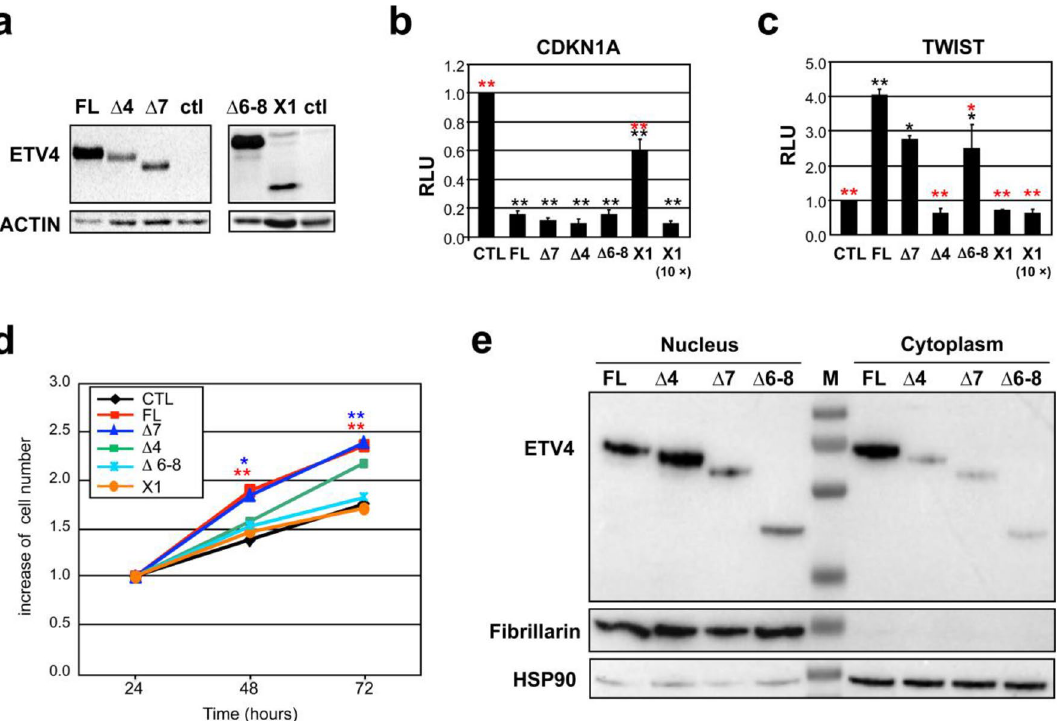
Figure 4. Functional characterization of proteins translated from the alternative ETV4 transcripts. ( a ) Western blot analysis of ETV4 isoforms expressed from 4 specific expression vectors: ETV4-∆4, ETV4-∆7, ETV4- ∆6–8, and ETV4-X1. FL, cells transfected with a vector expressing the full-length ETV4 (ETV4-FL). CTL, cells transfected with the empty vector. ( b-c ) ETV4 splice variants transcriptional activity measured by luciferase reporter assays. The vectors encoding each one of ETV4 splice variants or ETV4-FL have been transfected in RWPE cells along with a vector containing part of CDKN1A ( b ) or TWIST1 ( c ) promoter upstream firefly luciferase. Relative luciferase units (R.L.U.) is the firefly/renilla ratio of each variant compared to that obtained by control (CTL, cells transfected with the empty vector). The data represent mean ± sem from at least three independent experiments performed in triplicate: * P < 0.05, ** P < 0.01 (black asterisks: comparison with CTL; red asterisks: comparison with ETV4 FL). ( d ) Cell proliferation assessed by MTT assay in RWPE cells expressing the ETV4 isoforms. The values are expressed as increase of the initial cell number. Each value represents the average of 3 independent experiments. Cells transfected with any of ETV4-FL, ETV4 ∆7 and ETV4 ∆4 showed an increase of the proliferation rate, although this increase was statistically significant only for ETV4-FL and ETV4 ∆7 * P < 0.05, ** P < 0.01. ( e ) Expression of the ETV4 isoforms in the nucleus (left) and in the cytoplasm (right) of RWPE cells transiently transfected with the indicated ETV4 isoforms (∆4, ∆7 and ∆6–8) compared with the ETV4-FL (FL). Fibrillarin and HSP90 have been used as loading control for nucleus and cytoplasm, respectively. M: molecular weight